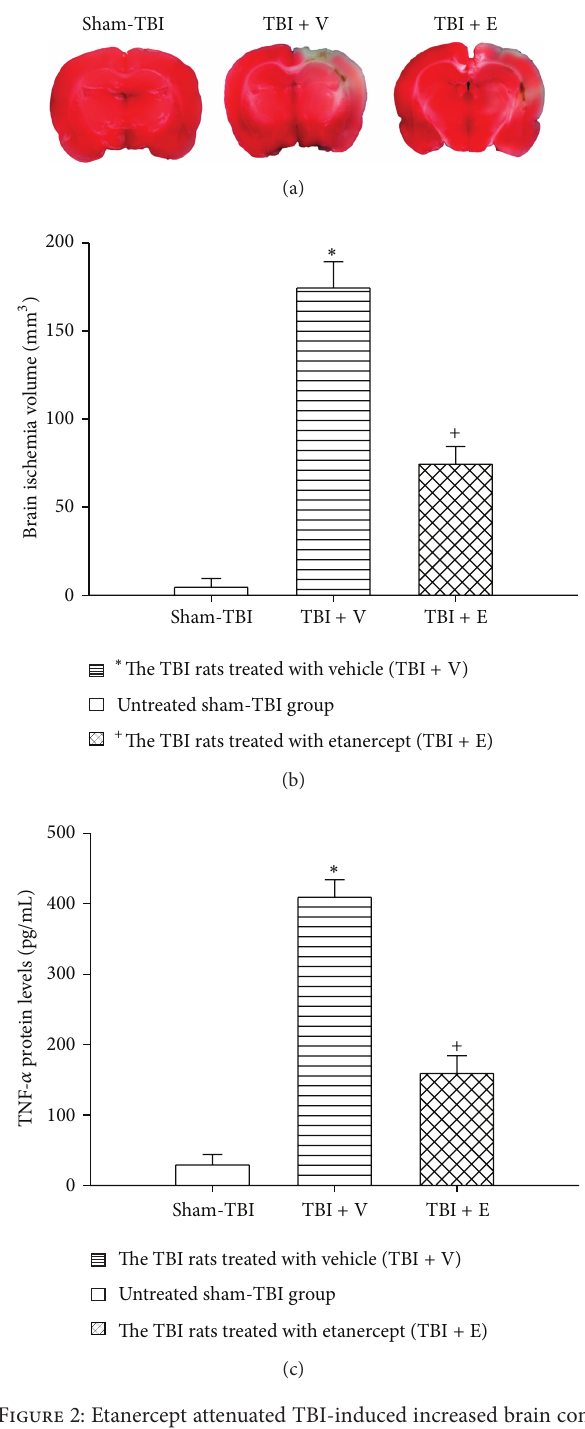
Figure 2: Etanercept attenuated TBI-induced increased brain con- tused volume and increased brain TNF- 𝛼 contents. ∗ The TBI rats treated with vehicle (TBI + V) (lined column; 𝑛 = 8 ) showed a significant increase in both brain contused volume and TNF- 𝛼 contents ( 𝑃 < 0.01 ) compared with the untreated sham-TBI group (white column) 7 days after TBI. + The TBI rats treated with etanercept (TBI + E) (crossed column; 𝑛 = 8 ) showed a significant decrease in both brain contused volume and brain TNF- 𝛼 contents ( 𝑃 < 0.05 ) compared with the (TBI + V) group (lined column; 𝑛 = 8 ). Top panels depict representative contused stainings for one sham TBI rat, one TBI + V rat, and one TBI + E